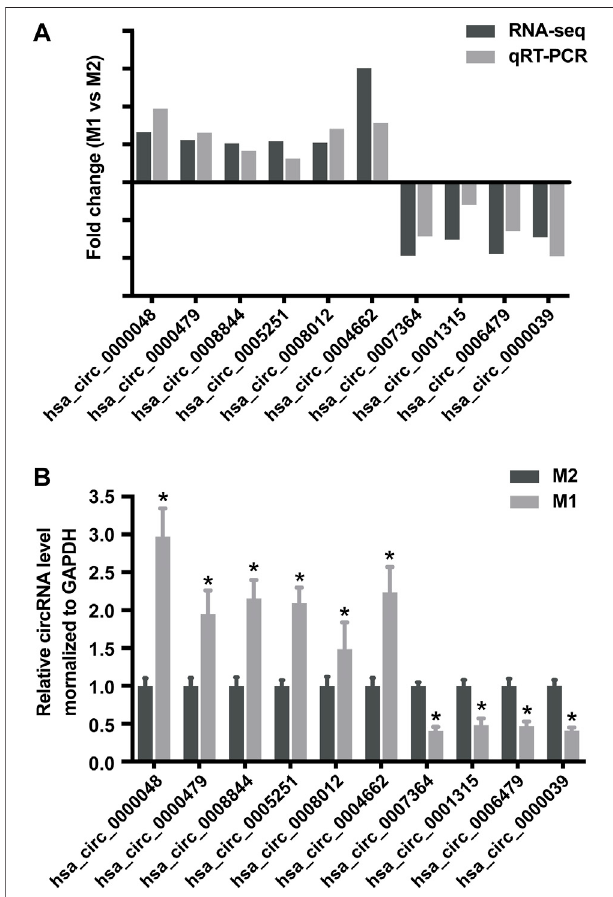
FIGURE 4 | Validation of RNA sequencing data using qRT-PCR. (A) Compared with the expression of 6 up-regulated circRNAs and 4 down- regulated circRNAs using sequencing and qRT-PCR analysis between M1 and M2 macrophages. (B) Validation the expression of 6 up-regulated circRNAs and 4 down-regulated circRNAs in M1 macrophages compared with M2 macrophages. Data are expressed as the means ± SD of at least three independent experiments. p < 0.05, signi fi cant difference between M1 and M2